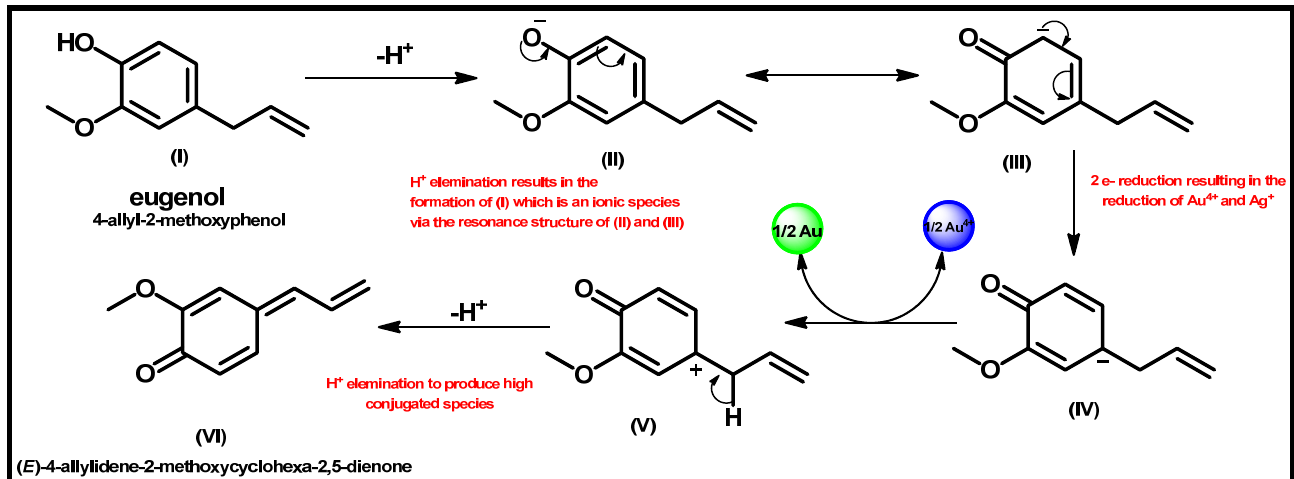
Figure 5. A schematic representation of the mechanism of reduction in Au 4+ and Ag + using plant extract containing a phytochemical like eugenol. Redrawn from [77], with permission from Springer Nature (Copyright 2022).